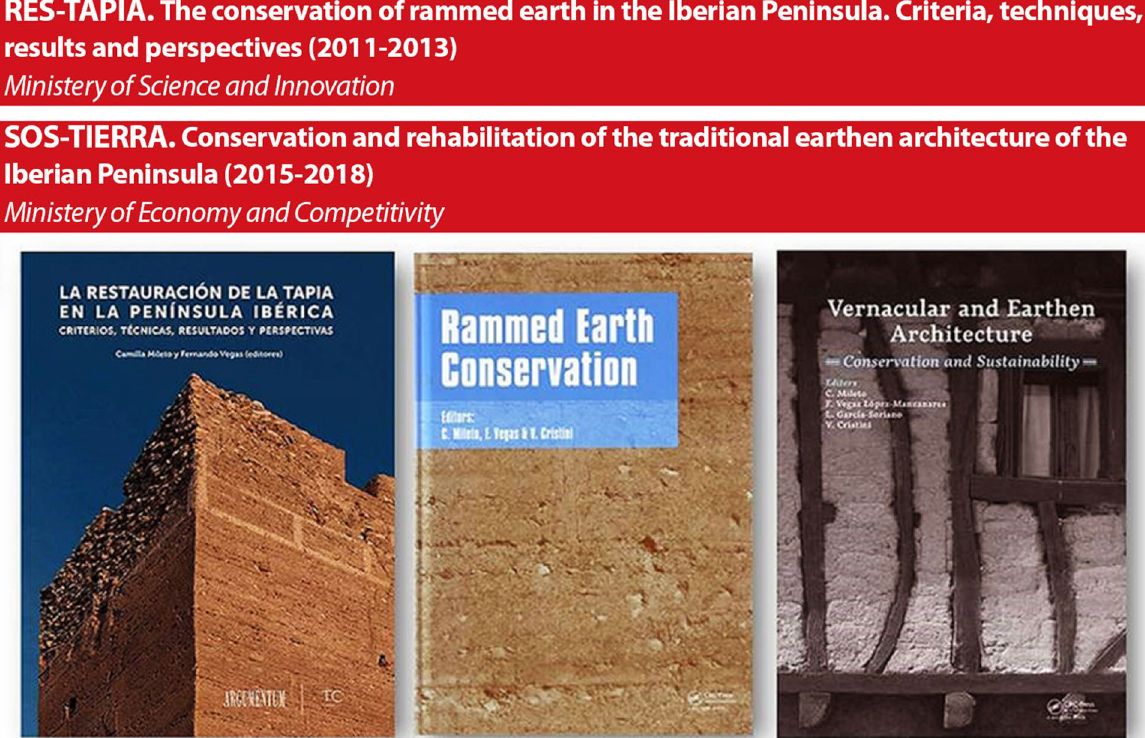
Fig. 6 Some relevant publications resulting from the research projects (Source: RES‑TAPIA & SOS‑TIERRA